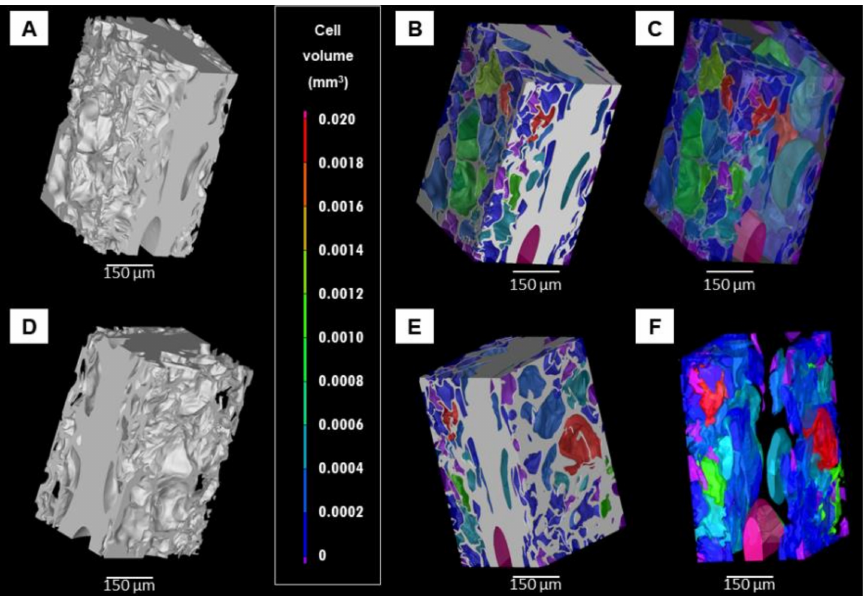
Figure 5. Three-dimensional (3D) virtual reconstructions of a lyophilized PVP hydrogel obtained by nano-CT. ( A , D ) Two different views of the material. ( B , C , E , F ) Pore volume distribution in colour- scale, images C and F are the same than images B and E, respectively, but the material was defined transparent for better observation of the pore morphology and